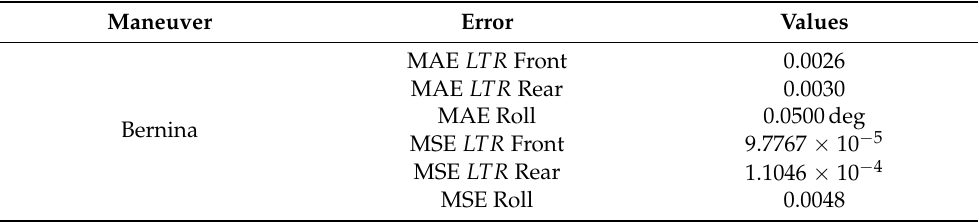
Table 4. Results: Mean Absolute Error and Mean Square Error related to the tested